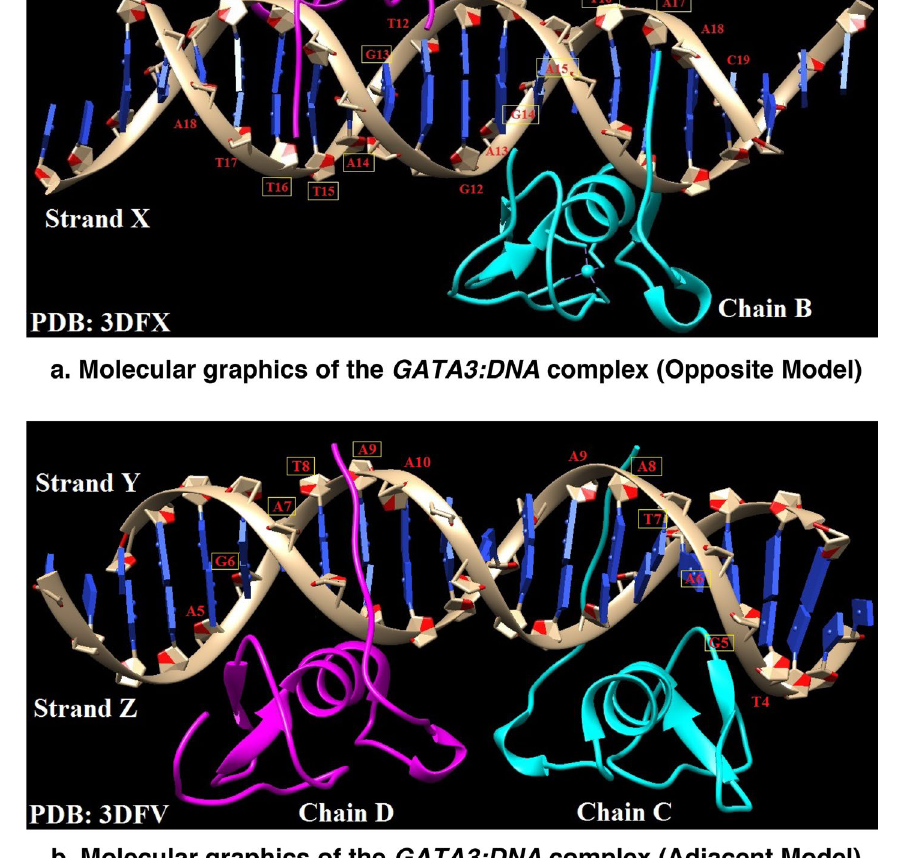
Figure 1. Molecular graphics of the GATA3:DNA complex. Analysis and visualization of the protein- DNA structure are performed using the visualization program Chimera 47 . In this GATA3:DNA complex, the net charge of GATA3 is − 38e and that of DNA is 16e. ( a ) Plot presents the Opposite (OPP) model showing Chain-B interactions with the DNA. ( b ) Plot presents the Adjacent (ADJ) model showing Chain-C interactions with the DNA , in a similar fashion to Chain-B interactions with the DNA in the OPP